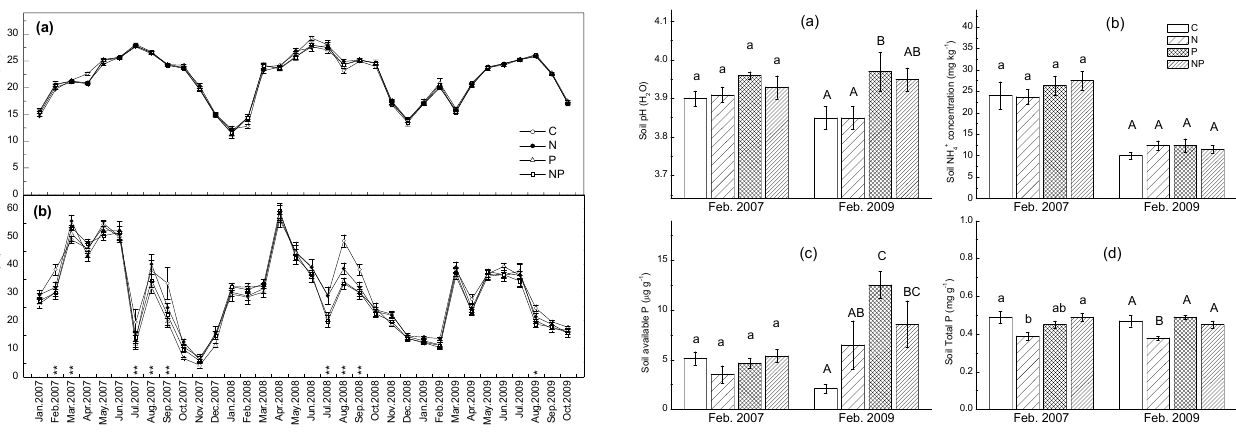
Fig. 1. Soil temperature at 5cm depth (a) and soil WFPS (b) dur- Figure 1. Soil temperature at 5cm depth ( a ) and soil WFPS ( b ) during the study ing the study period. Error bars represent standard error of means period. Error bars represent standard error of means (N = 5). Asterisk (*) and double (N=5). Asterisk ( ∗ ) and double asterisk ( ∗∗ ) indicates significant asterisk (**) indicates significant differences between control and at least one of the differences between control and at least one of the experiment treat- ments at p < 0 . 1 and p < 0 . 05, respectively. experiment treatments at p < 0.1 and p < 0.05, respectively.